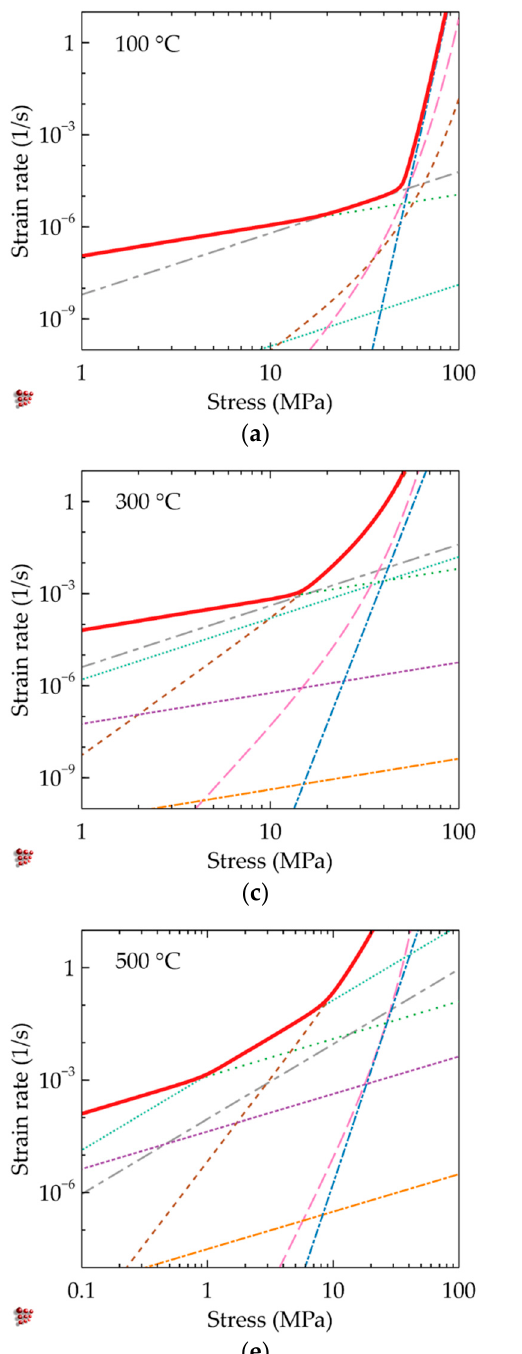
Figure 2. Dislocation glide (G), LT creep (LT), HT creep (HT), Nabarro–Herring creep (NH), Coble creep (C), Harper–Dorn creep (HD), and D gb - and D l -controlled GBS (GBS_GB and GBS_L) at di ff erent constant strain rates at ( a ) 100 °C; ( b ) 200 °C; ( c ) 300 °C; ( d ) 400 °C and ( e ) 500 °C. The resulting stress, σ ges , of Equation (21) is displayed as bold line